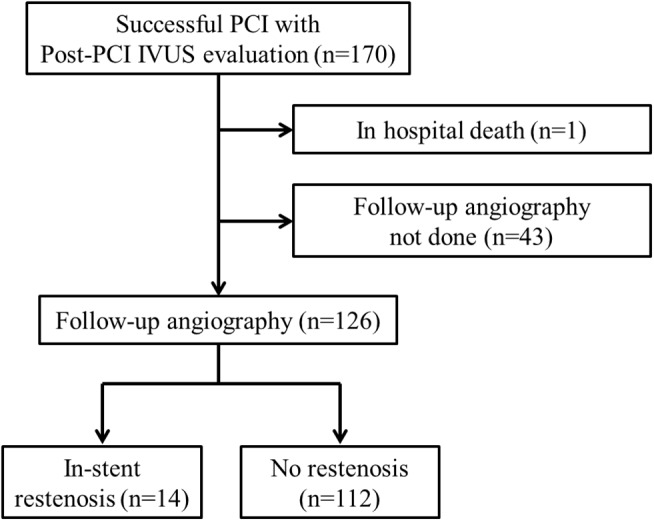
Study profile of the patients.